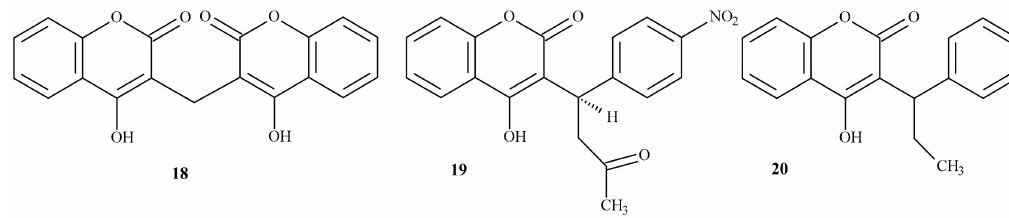
Figure 8. 4-Hydroxy-coumarin drugs. ( 18 ) dicoumarol; ( 19 ) acenocoumarol; and ( 20 )